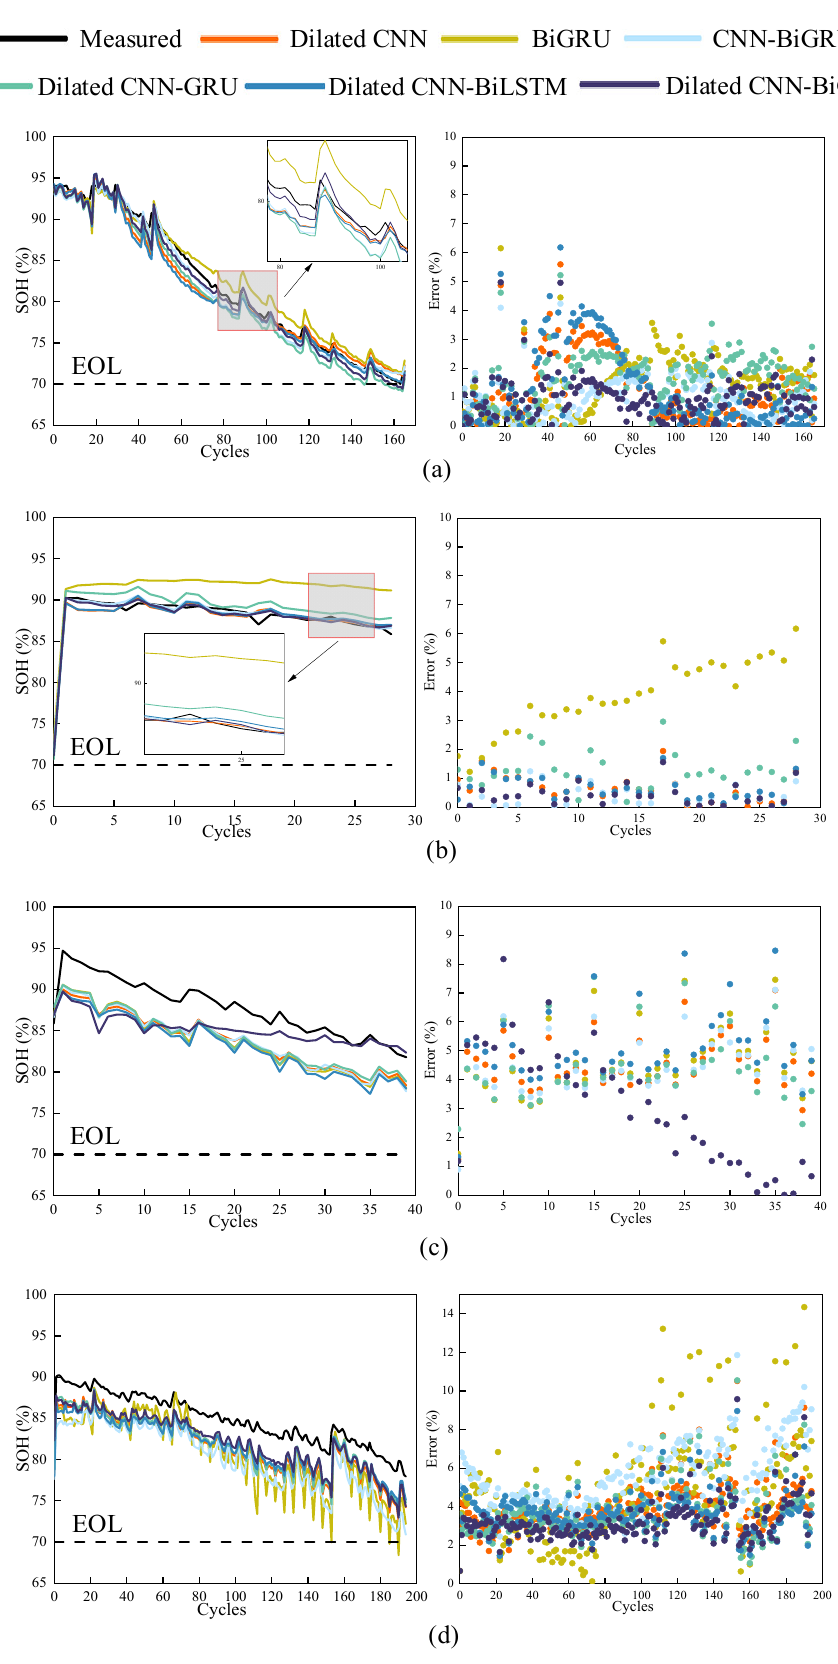
Figure 10. Estimation accuracy and estimation error of the testing set for the NASA dataset. ( a ) B0007, ( b ) B0028, ( c ) B0032, and ( d ) B0036.